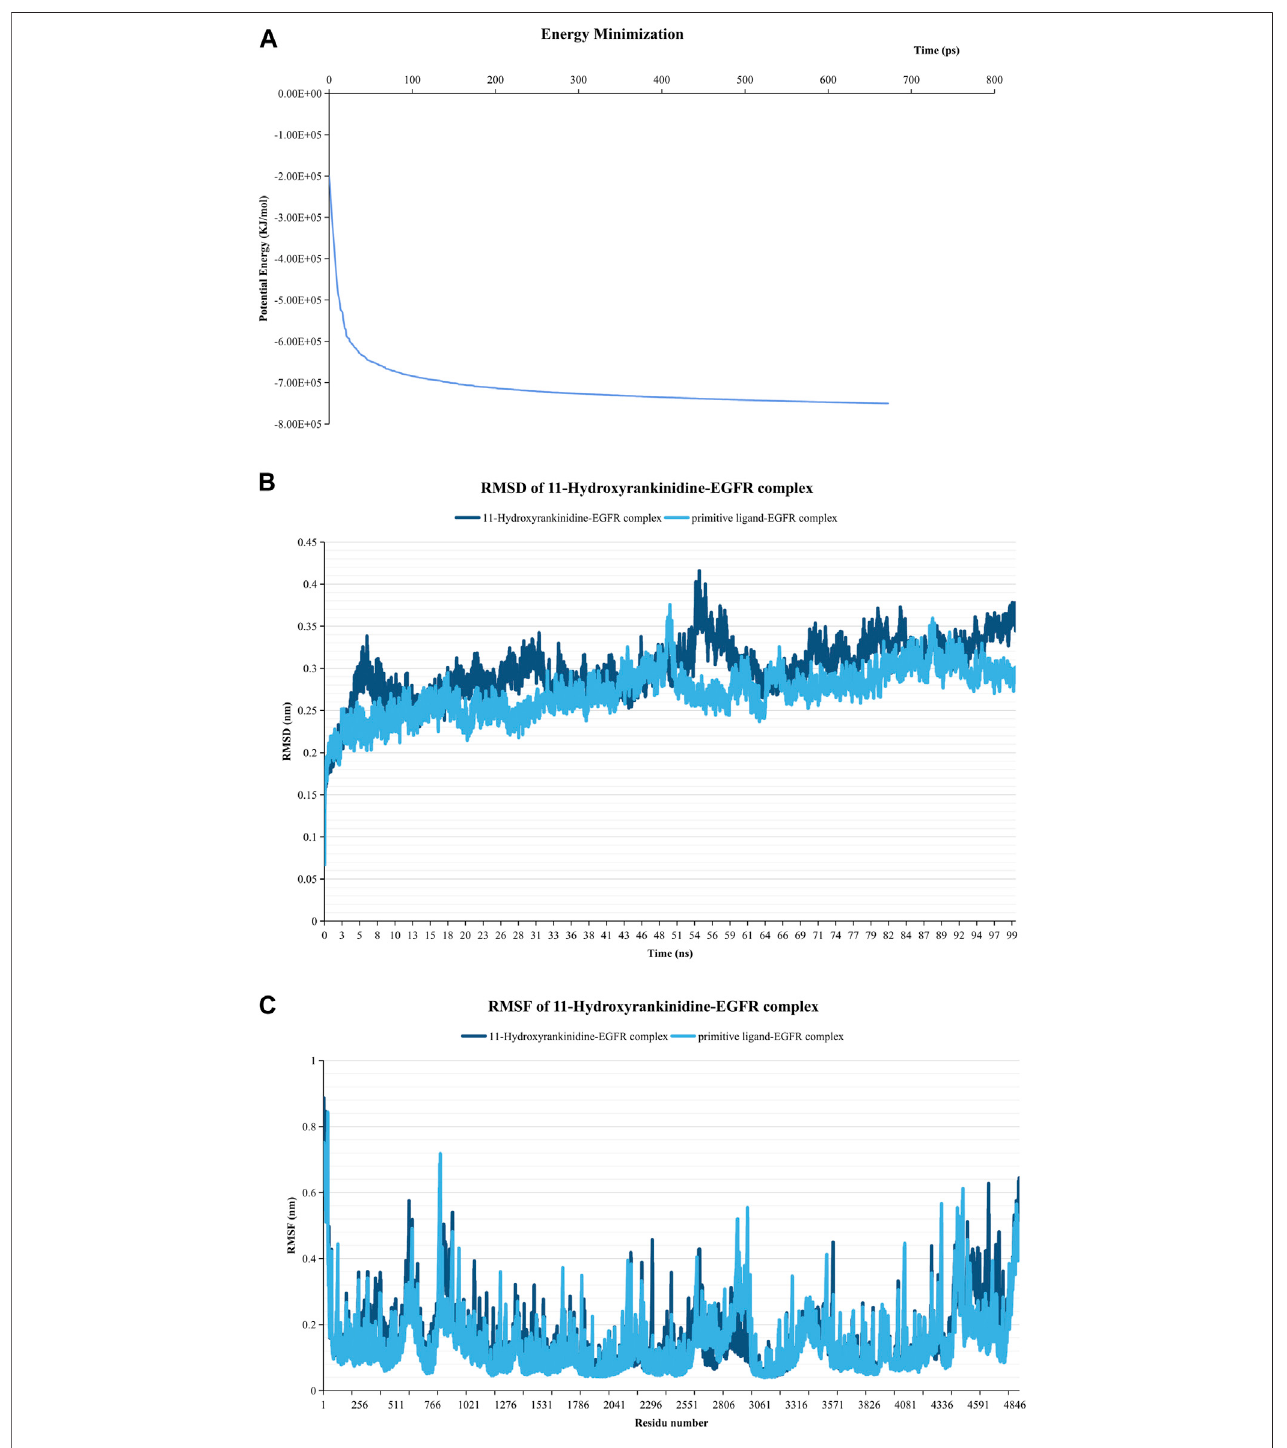
FIGURE 7 | Molecular dynamics simulation of the 11-Hydroxyrankinidine-EGFR complex. (A) Energy minimization for molecular dynamics simulation. (B) RMSD pro fi les of complex conducted during 100 ns. (C) RMSF pro fi les of the complex. The primitive ligand of EGFR is ibrutinib.